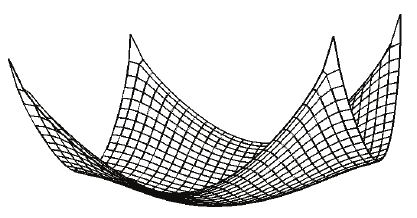
Figure 7: Sketch of three-dimensional deformed shape of the geosynthetic